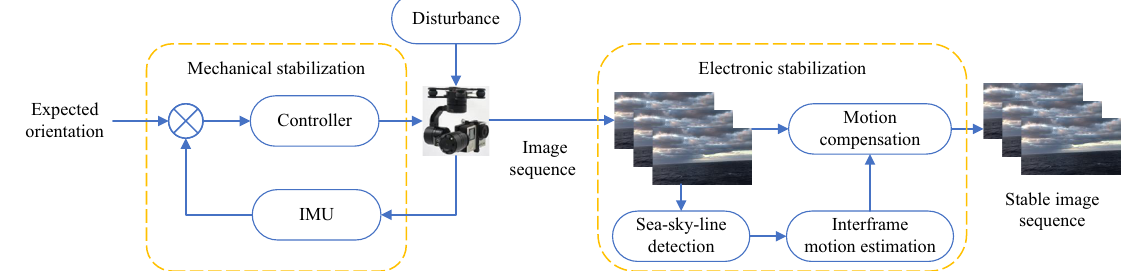
Figure 1. Flowchart of hierarchical video stabilization control